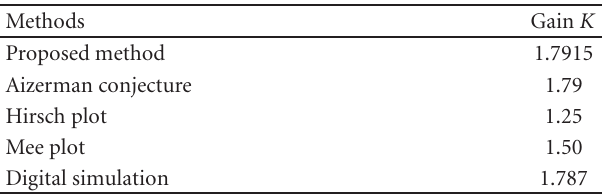
Figure 8: Time responses with two double-valued nonlinearities. Table 2: The gains K for just having a limit